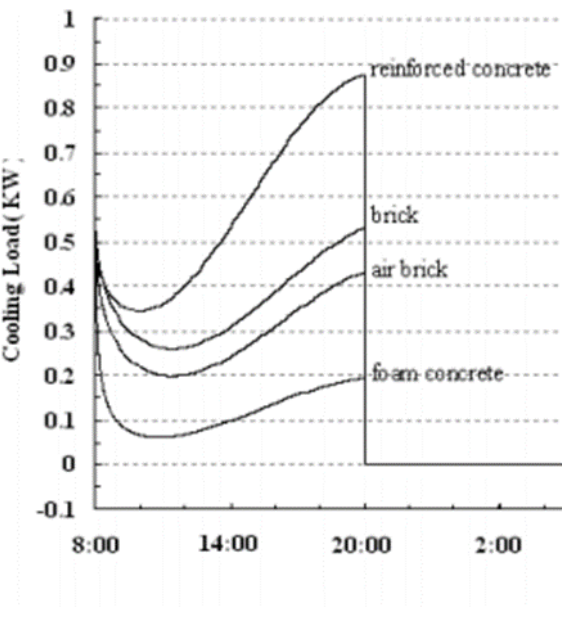
Fig. 4. Effect of night ventilation on cooling load from 8 AM to 8 BM for different wall materials (Source: